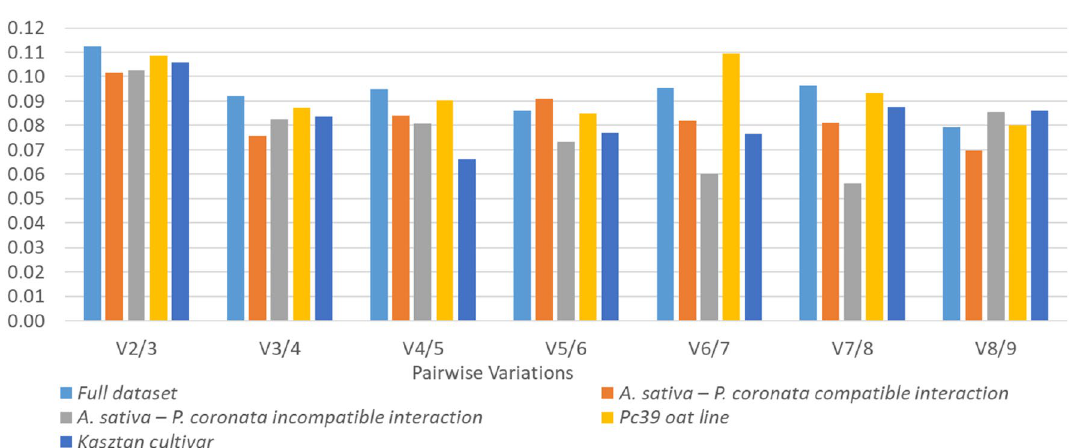
Figure 6. Pairwise variation (Vn/Vn + 1) analysis performed by geNorm algorithm for determination of the optimal number of RGs for accurate qPCR data normalization. A value < 0.15 indicates no need for additional RG